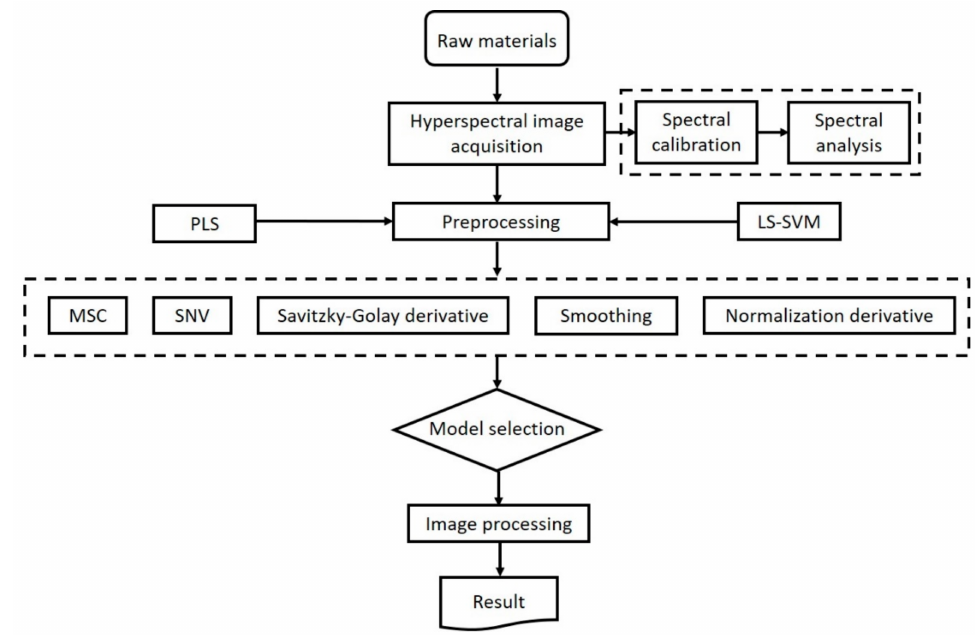
Figure 2. Workflow of HSI analysis for qualitative and quantitative evaluation of OF FW components.